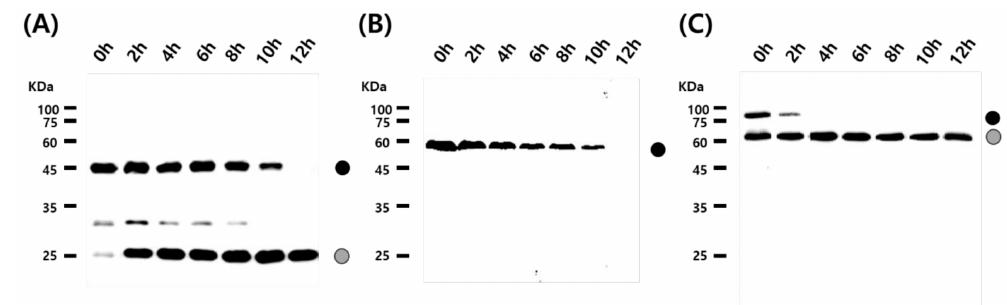
Figure 5. Self-cleavage activity of the Ssp DnaB mini-intein in fusion proteins by temperature and pH adjustments. Recombinant proteins fused with the Ssp DnaB mini-intein were prepared at 72 h.p.i and then treated at pH 7.0 and 25 °C for 12 h. Protein samples were collected at intervals of 2 h and analyzed by ( A ) Western blot with anti-GFP mAb, ( B ) anti-CSFV-E2 mAb ( C ) anti-PPV-VP2 polyclonal antibodies. The black circle represents the fusion-expressed recombinant protein with His6 and the Ssp DnaB mini-intein. The gray circle represents each recombinant protein released from the fusion protein by cleavage of the mini-intein.